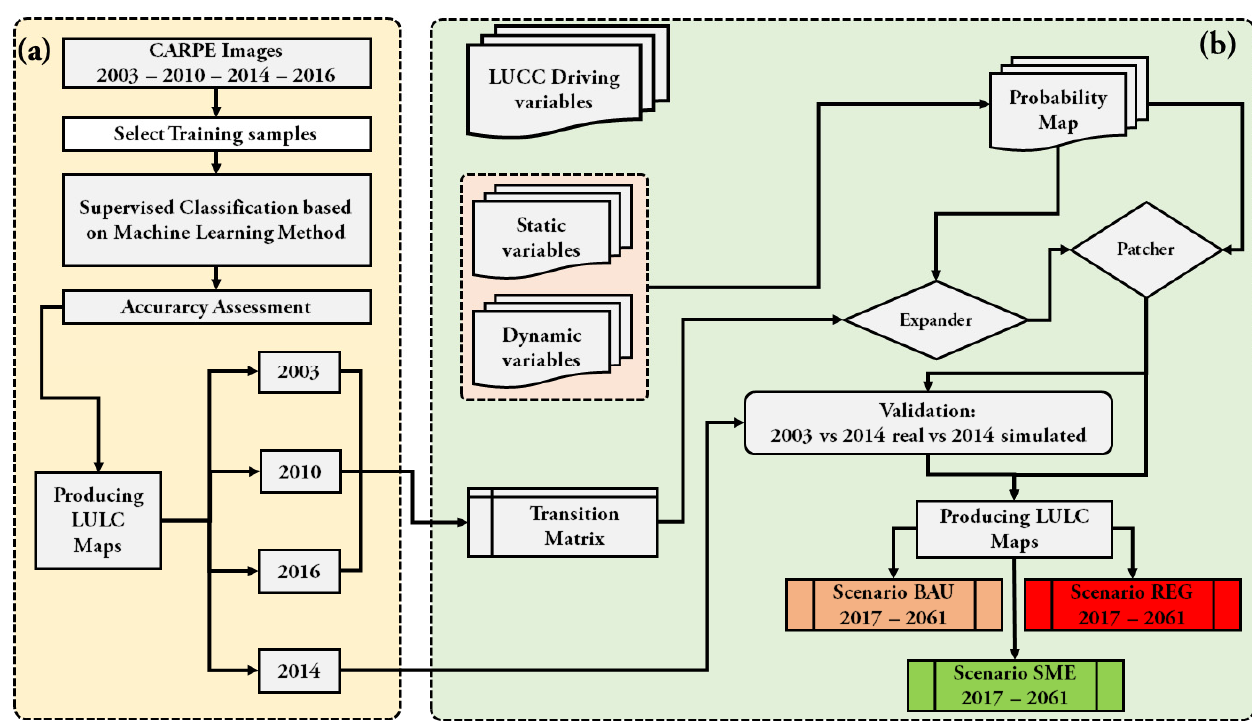
Figure 2. Workflow of the study: ( a ) Land use and land cover (LULC) classification; ( b ) Modeling of deforestation. Abbreviations: CARPE, The Central Africa Regional Program for the Environment; LUCC, Land use and cover changes; LULC, Land use and land cover.